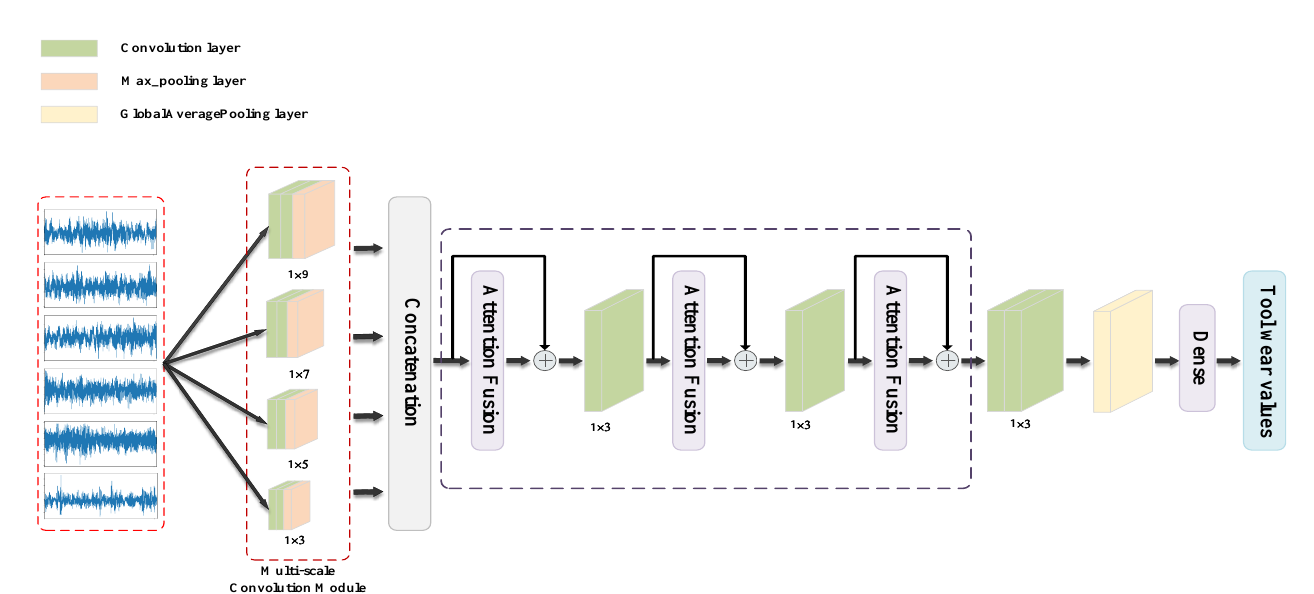
Figure 3. Network structure diagram of tool wear prediction.